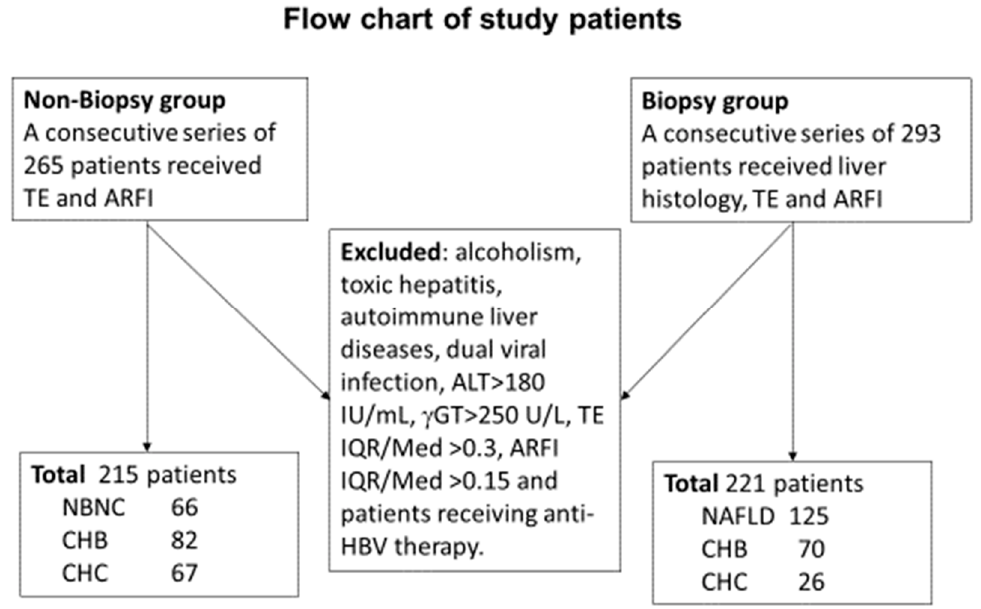
Figure 1. Flow chart of study patients.